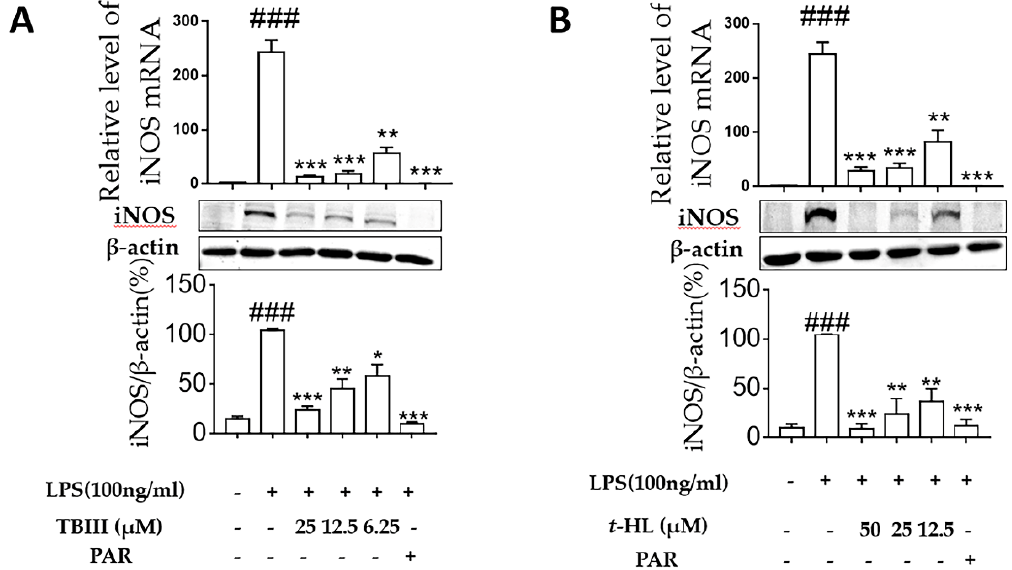
Figure 3. Effects of TBIII ( A ) and t -HL ( B ) on the expression of iNOS induced by LPS in N9 microglial cells. The iNOS protein levels were analyzed by Western blot. Cells were treated with different concentrations of TBIII and t -HL for 1 h and then stimulated with LPS (100 ng/mL) for 24 h. The iNOS signal was normalized to the β -actin signal. Parthenolide (PAR, 10 µ M) was used as a positive control. The data were obtained from three independent experiments and expressed as the means ± S.E.M.